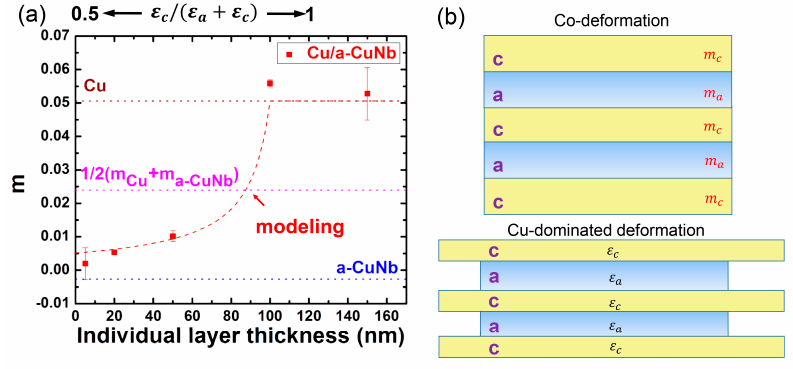
Figure 6. ( a ) SRS as a function of individual layer thickness ( h ) of Cu/a-CuNb multilayers. The SRS of a-CuNb, Cu, and their average values were added as dotted lines. When h < 50 nm, the SRS of Cu/a-CuNb multilayers decreases with decreasing h . When h > 100 nm, Cu/a-CuNb multilayers have an apparent SRS value similar to that of the single layer Cu film. The modeled curve (dashed line) indicates strain distribution from Cu and a-CuNb as a function of h . ( b ) A schematic showing the different deformation mechanisms at different h . When h is small (<50 nm), dislocation activities are limited and crystalline and amorphous layers can co-deform; when h is relatively large (>100 nm), deformation is dominated by dislocation activities, and crystalline layers accommodate more strain than amorphous layers.